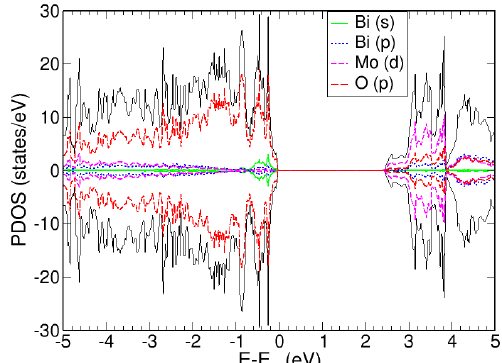
Figure 2. Projected density of states (PDOS) for Bi 2 MoO 6 . Energies (E) on the x -axis are referenced to the Fermi level (E F ). All PDOS below E-E F = 0 eV represent occupied states (valence band), whereas those above E-E F = 0 eV, are unoccupied states (conduction band). In addition, positive PDOS values are the α -spin occupations and negative PDOS values are β -spin occupations.